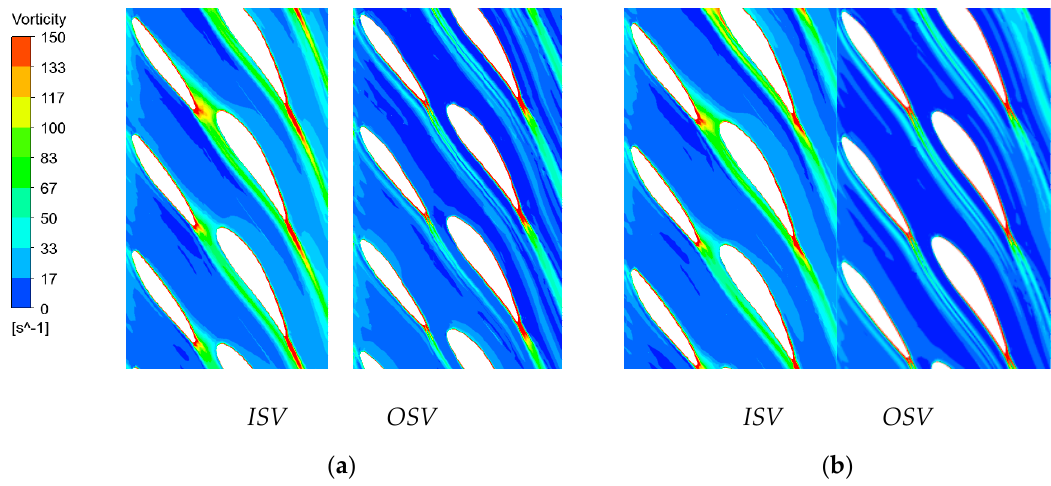
Figure 17. Comparison of vorticity in ISV and OSV flow passages ( a ) 0.25 span and ( b ) 0.75 span at design point.